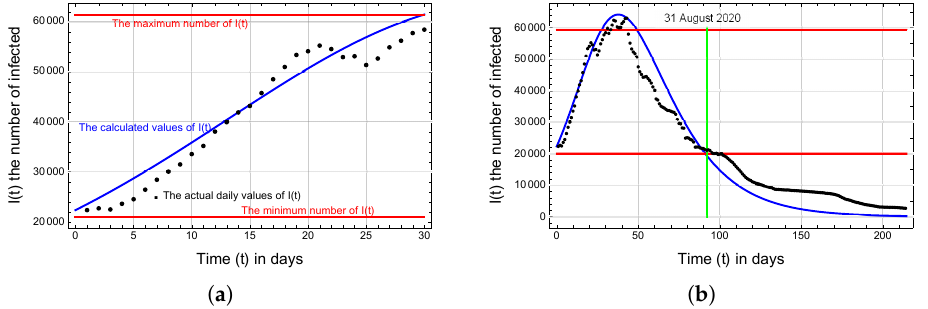
Figure 5. The behavior of the daily infected cases due to parameter determined from the data of June. ( a ) Calculated and actual active daily infected cases along small period of time (June). ( b ) Calculated and actual active daily infected cases along long period of time (from June to end of 2020).